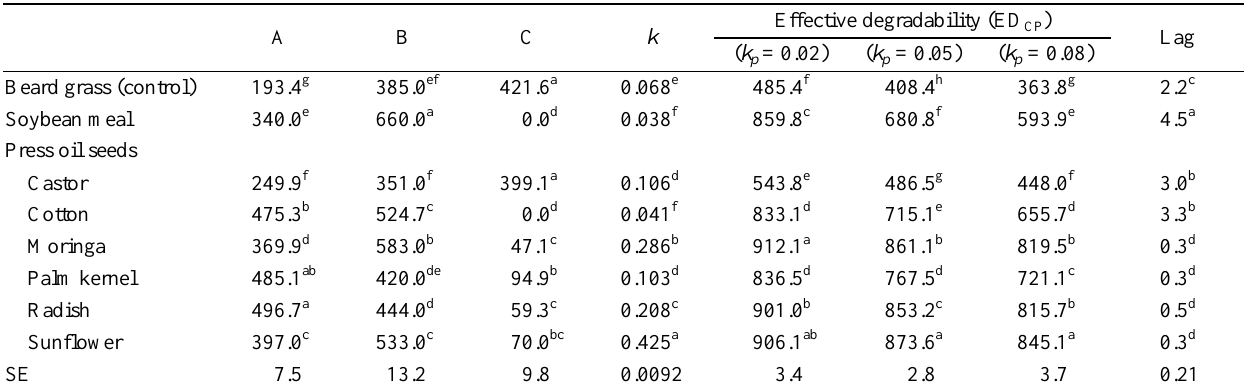
Table 3. Experimental diets crude protein degradation characteristics (in g/kg) as defined by soluble (A), degradable insoluble